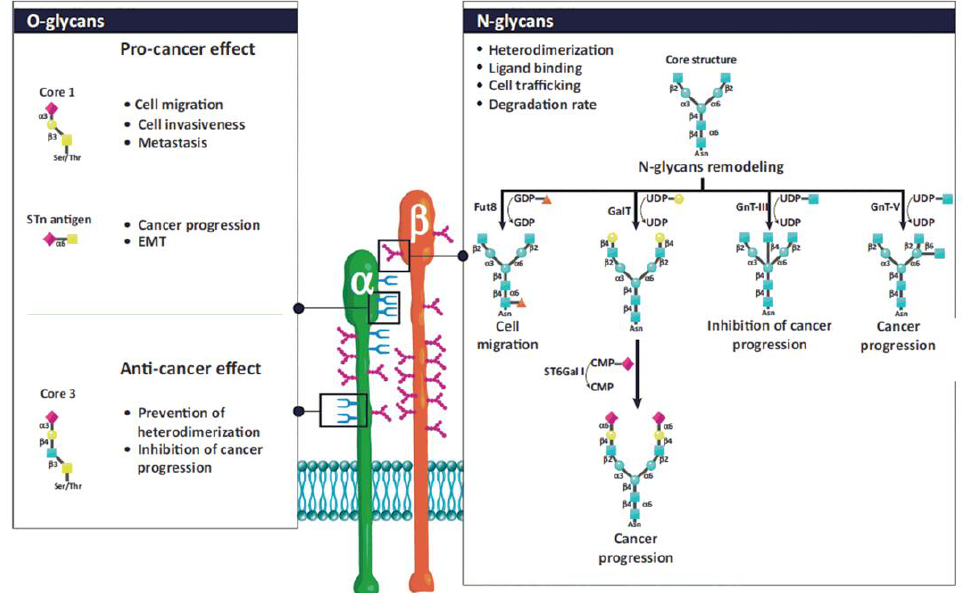
Figure 3. Schematic representation of N - and O -glycosylation of integrins by glycosyltransferases and associated functions. The N -glycan structure is involved in heterodimerization, ligand binding, cell trafficking, and the degradation rate of integrins. N -glycans regulate cell adhesion and migration and, consequently, cancer progression. Fut 8, α 1,6-fucosyltransferase; GalT, hydroxyproline-O-galactosyltransferase; GnT-III, β 1,4-N-acetylglucosaminyltransferase III; GnT-V, β 1,6 N-acetylglucosaminyltransferase V; ST6Gal-I, ST6 β -galactoside α 2,6-sialyltransferase I. Reprinted with permission from reference